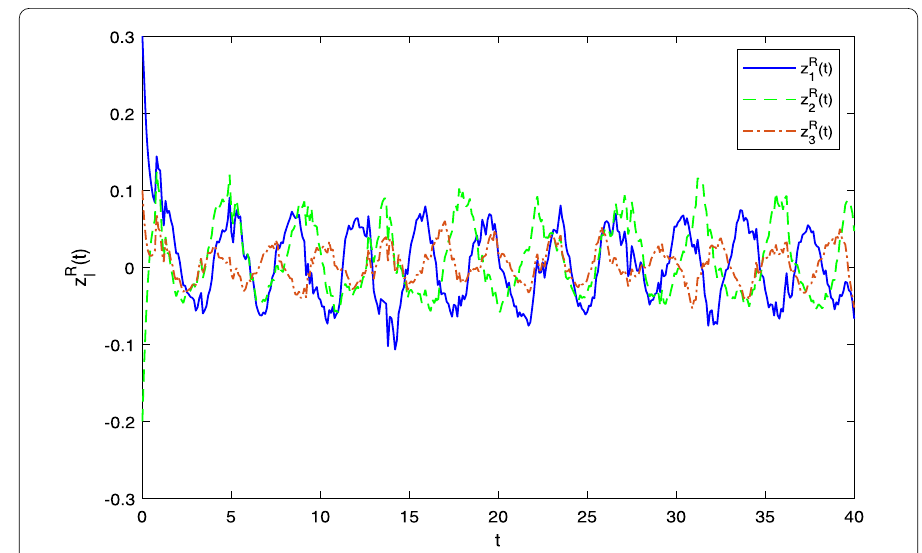
( t ) (cid:12) = 0, l = 1,2,3 l